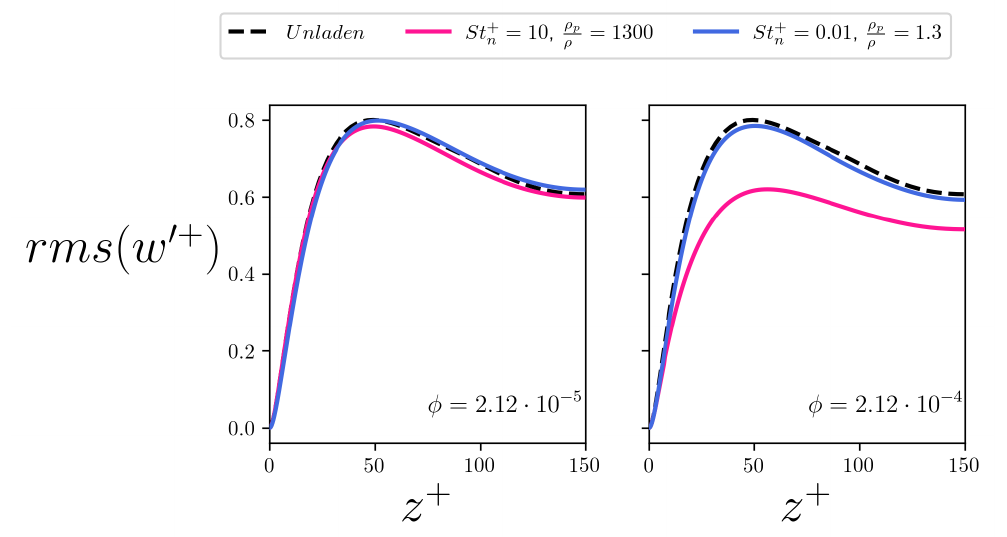
Figure 16. Root mean square (rms) of the wall-normal fluid velocity along the wall-normal coordinate. The left panel refers to the φ = 2.12 · 10 − 5 case, the right panel refers to the φ = 2.12 · 10 − 4 case. The curves relative to the St + n = 0.01 fibers are plotted in blue while the curves relative to the St + n = 10 fibers are plotted in pink. The curve of the unladen flow case is plotted in dashed black for